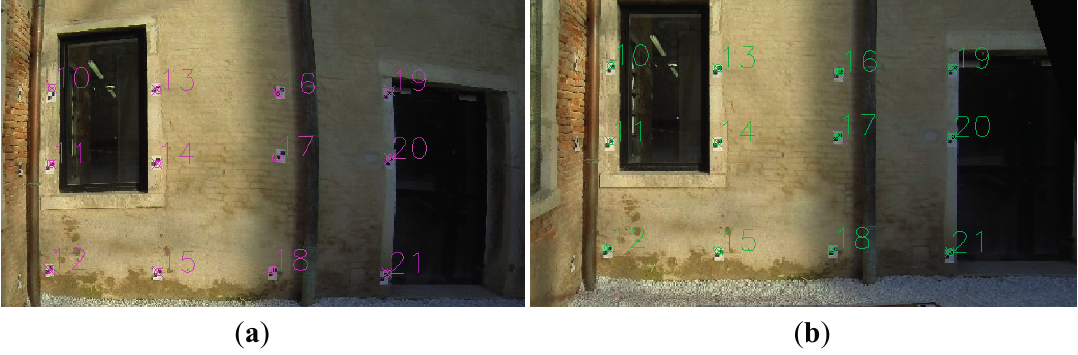
Figure 17. The rectification of the original ( a ) and undistorted GoPro images ( b ) lead to an RMS error of the collected GCPs of 0.0103 m and 0.002 m respectively using the VeCAD-Photogrammetry application [20]. It is also visible the curvature of straight lines on the original image (a).